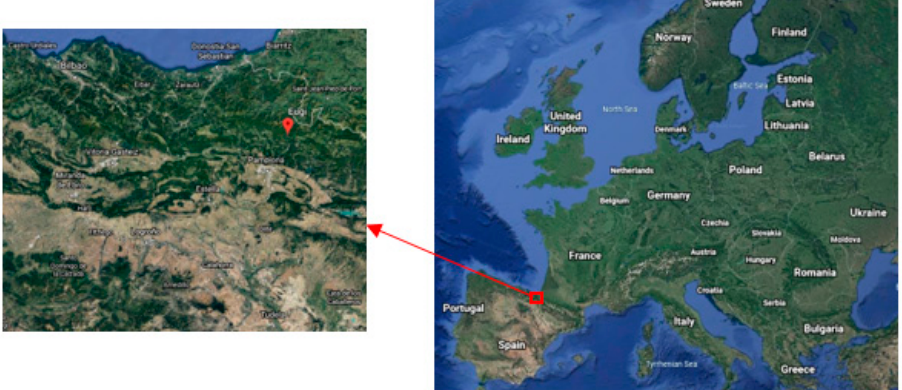
Figure 1. Map of Europe and Navarre, Eugi village is marked with a bullet-point in red. Images taken from Google Earth [24].